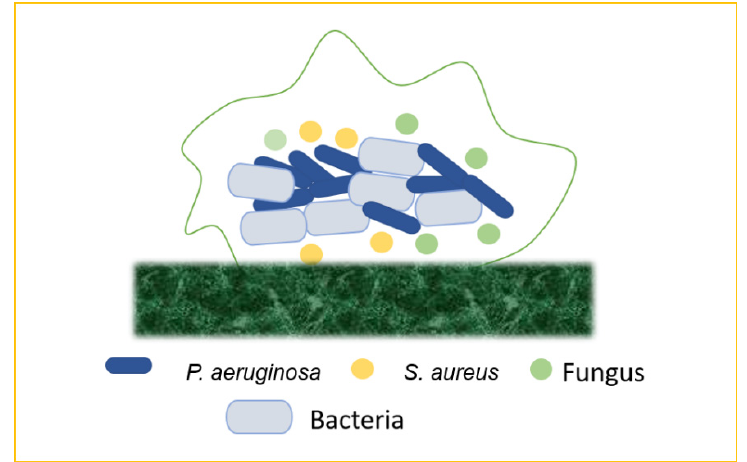
Figure 8. Mixed biofilms (bacteria–bacteria; bacteria–fungus;